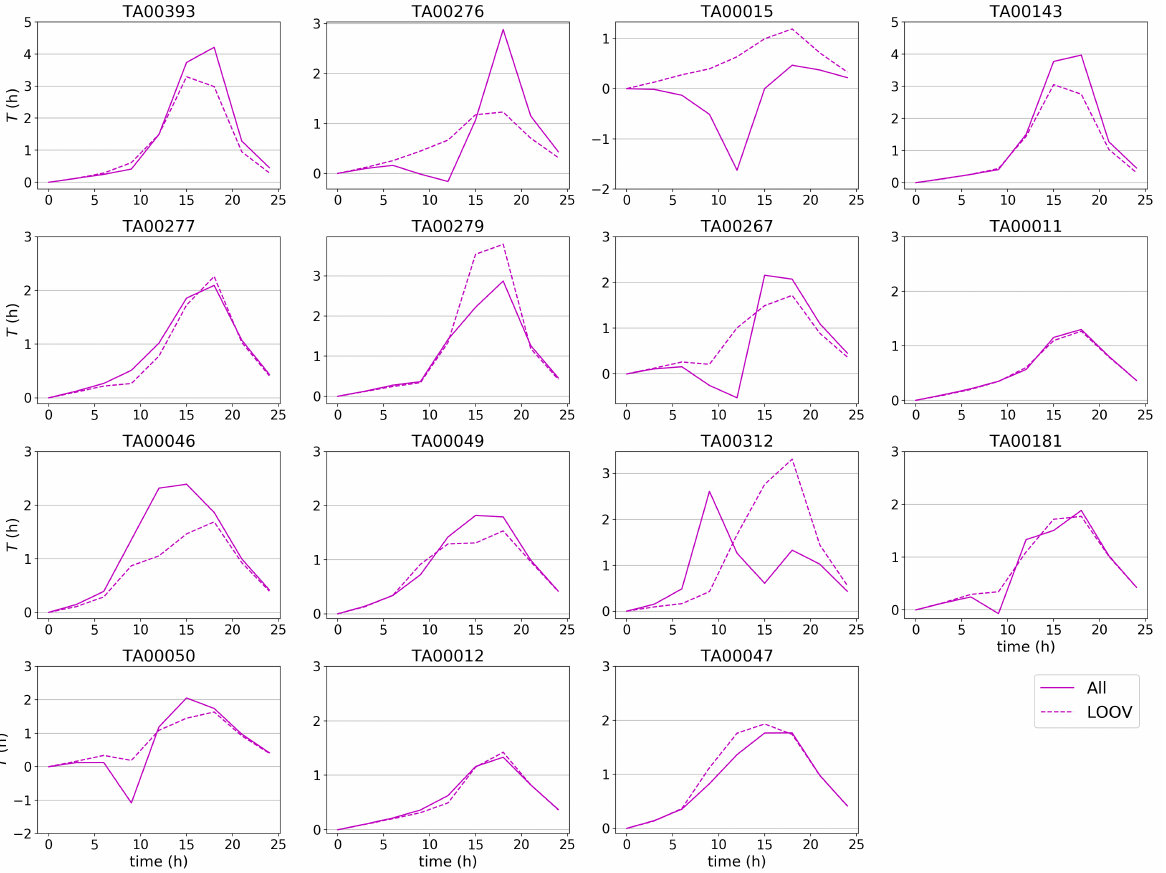
Figure 13. Mappings at the station locations obtained from the “All” (continuous line) and “LOOV” (dashed line) experi- ments. Only the stations with more than 0.1 mm/h of rainfall according to both TAHMO and IMERG are